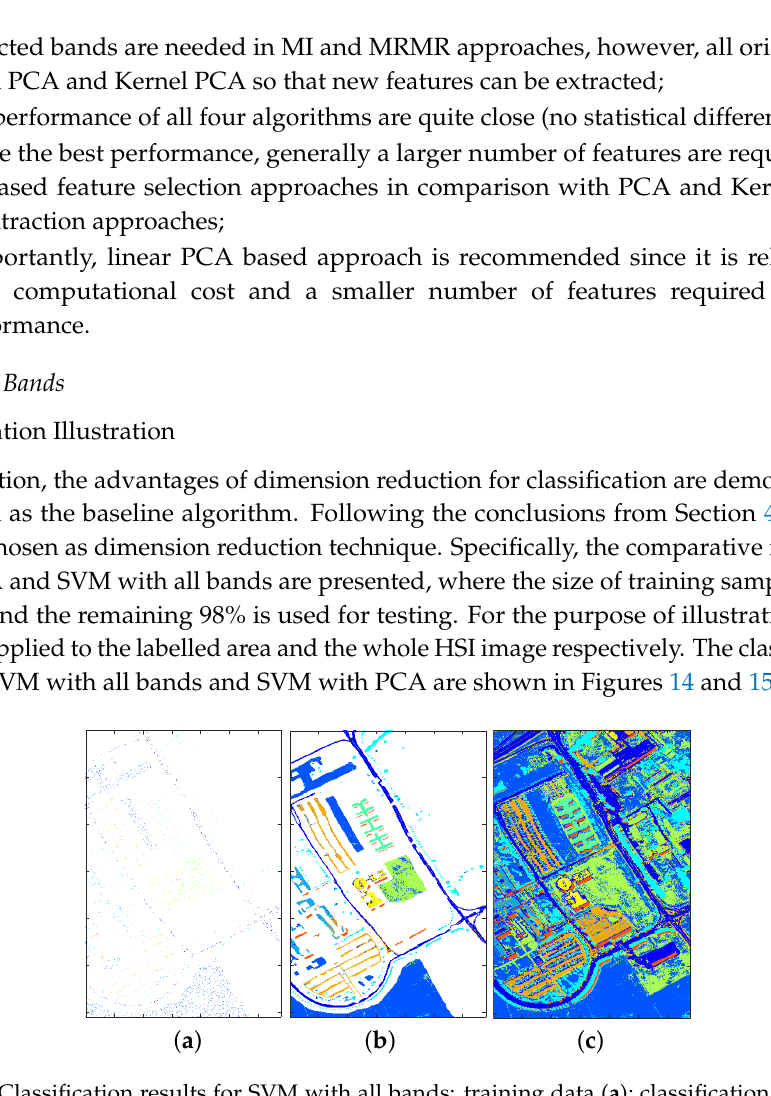
Figure 14. Classification results for SVM with all bands: training data ( a ); classification map for all labelled area ( b ); classification map for whole image ( c ).